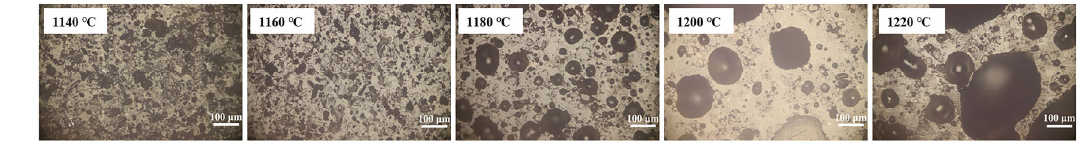
Figure 19. Microscope images of the samples sintered at different temperatures for 20